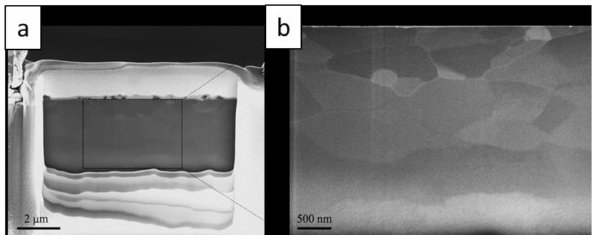
Figure 5. Focused ion beam. ( a ) Aluminum–TiB 2 nanocomposite sample sheet prepared by FIB. ( b ) High-magnification SEM images obtain from the rectangular box (from a ) vividly showing the ultra-fine-grain aluminum.